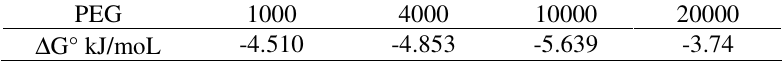
Table 4. Adsorption constants and thermodynamic parameter of PEG